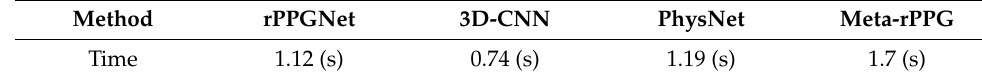
Table 6. Latency or computation time for the four compared deep learning methods.